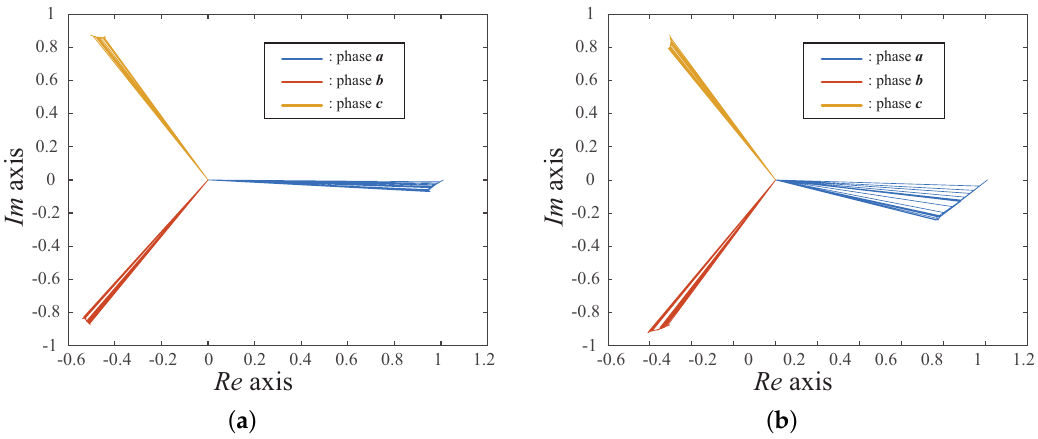
Figure 16. Phasor representation of three phases: ( a ) initial condition and ( b ) unbalanced condition.